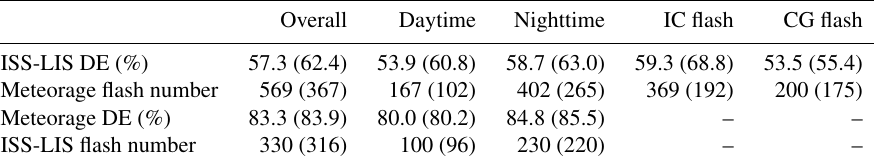
Figure 5. Flash category histogram (a) and spatial distribution (b) while matching ISS-LIS and Meteorage flashes for the available ISS overpasses from March 2017 to March 2018. Categories show the number of Meteorage flashes seen by ISS-LIS: both (Meteorage flashes), the number of ISS-LIS flashes also detected by Meteorage (both LIS flashes), and flashes detected either by Meteorage (Meteorage-only) or ISS-LIS (LIS-only). The numbers of single-element flashes (event for ISS-LIS, pulse or stroke for Meteorage) are marked for each category as indicated. Table 1. Relative detection efficiencies (DEs) of Meteorage and ISS-LIS. The values in parentheses give the relative DEs for flashes with at least two elements. The flash numbers (100%) to calculate the DEs are indicated. Note: ISS-LIS (Meteorage) DE uses Meteorage (ISS-LIS) flash